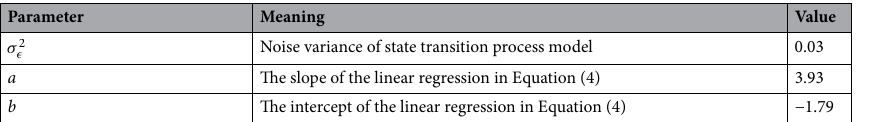
Table 1. State transition process model parameters. These parameters are estimated using LS method and they are assumed to be constant for all of the driving tests. In other words, state transition process of PERCLOS (Equation 1) has the same parameters in different driving tests.